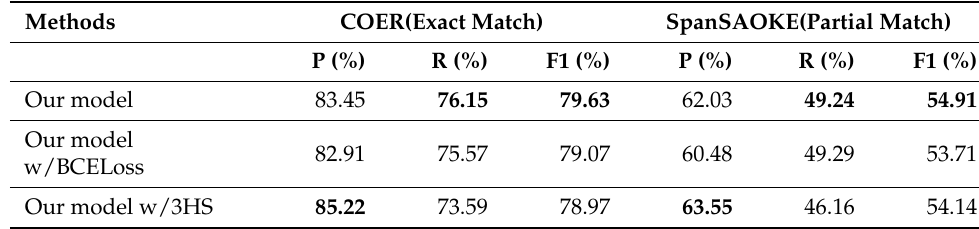
Table 5. The results of ablation